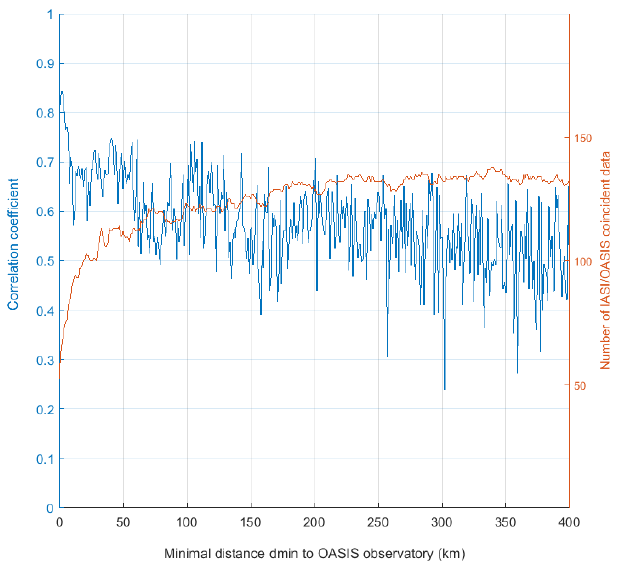
Figure 9. Regression slope (blue lines, left axis) between IASI and ground-based FTIR observations with temporal sampling difference smaller than 30min, as a function of d min to OASIS observatory, considered for the calculation of the 15km wide rings. The data (orange lines, right axis) show the total number of IASI–OASIS coincident